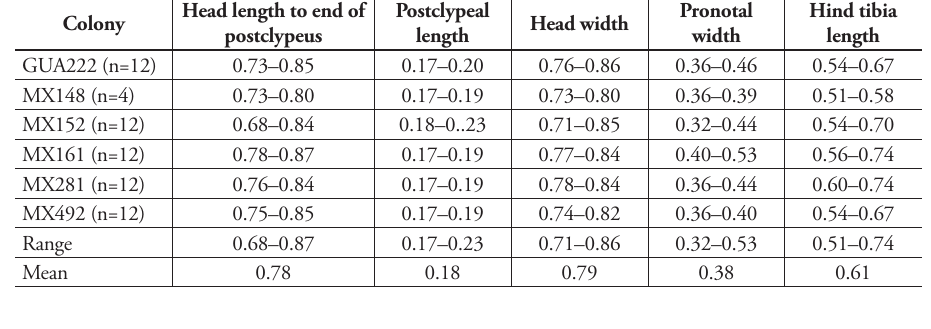
Table 6. Measurements (mm) of Parvitermes yucatanus sp. n. workers.